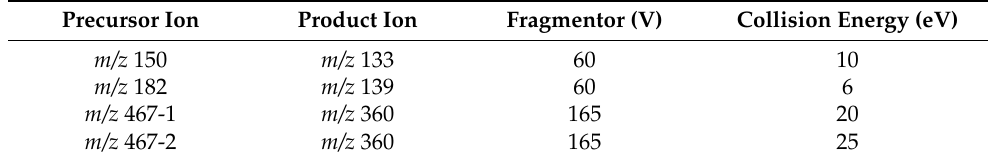
The optimal parameters of target compounds for Multiple Reaction Monitoring (MRM)